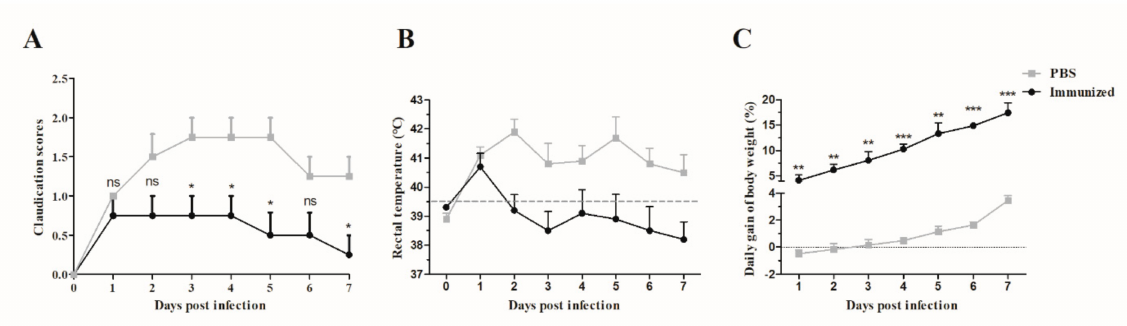
Figure 5. Clinical score ( A ), rectal temperature ( B ), and body weight ( C ) in the vaccinated piglets after the challenge with SS2. Signs of rectal temperature and body weight were monitored for 7 d post-infection. In ( A ), an unpaired Student’s t -test showed that the clinical score in the immunized piglets was significantly lower than in PBS-immunized piglets. In ( B ), recovery was indicated at a rectal temperature below 39.5 ◦ C. In ( C ), an unpaired Student’s t -test showed that daily gain of body weight in the immunized piglets was significantly higher than in the PBS-immunized piglets. Samples collected from each piglet were tested in triplicate. *** p < 0.001, ** p < 0.01, * p < 0.05, and ns ( p > 0.05). The error bars represent